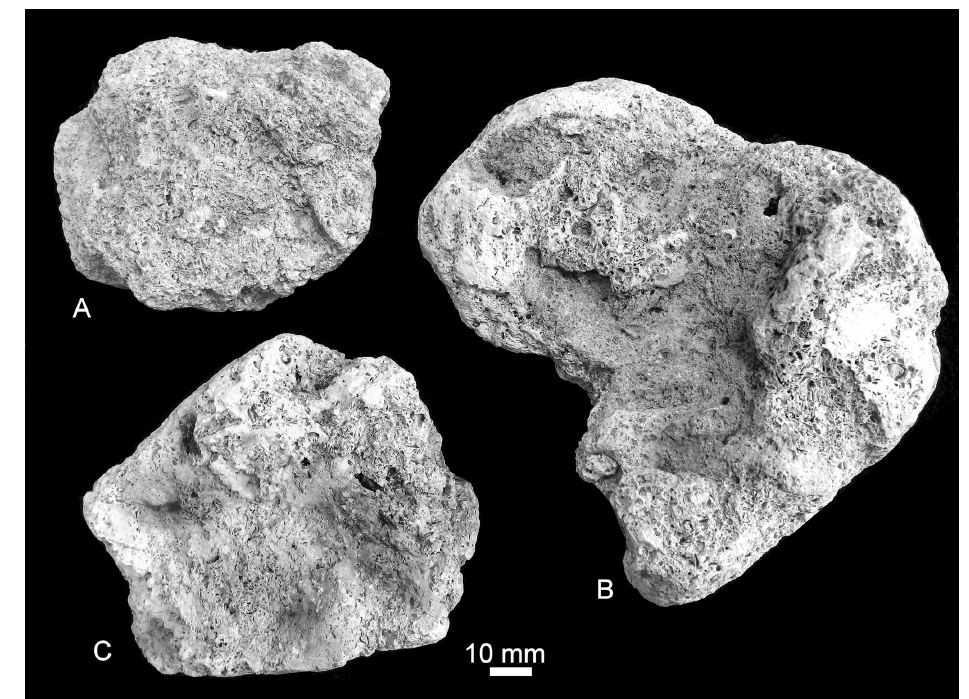
Fig. 4. Boulders of baksteenkalk type 2B: A, RGM 1317634, Wilsum; B, RGM 1317635, Kloosterhaar; C, RGM 1317636,